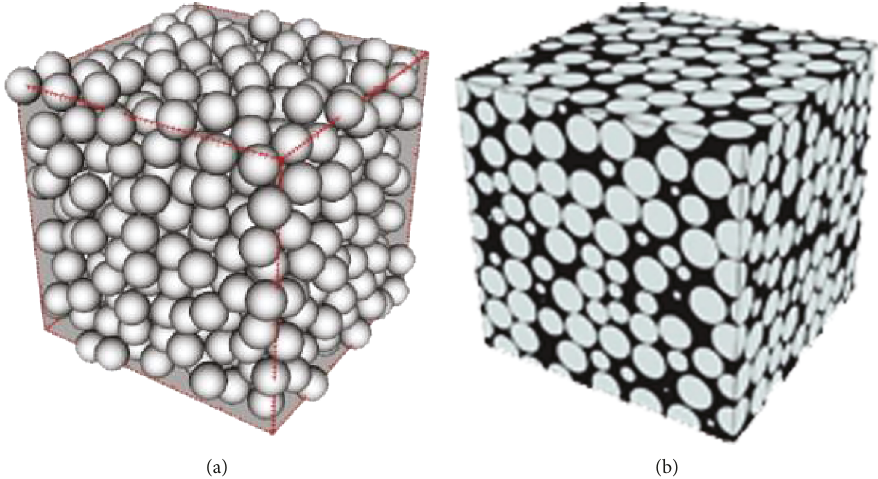
Figure 12: Geometry process in physics process-based stochastic reconstruction method. (a) Shows 3D digital core results before meshing, and (b) shows 3D digital core results after meshing. Figure from [63].